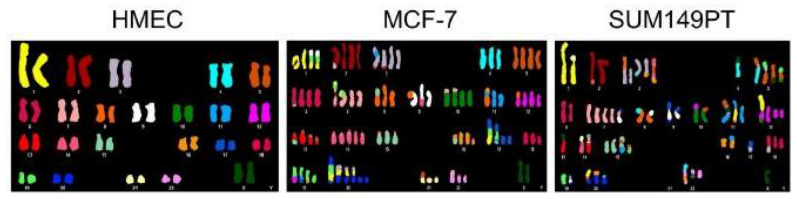
Figure 3. Cell lines derived from cancers exhibit numerical and segmental aneuploidy. Spectral karyotype comparison of normal human mammary epithelial cells (HMEC) and two breast cancer cell lines (MCF-7 and SUM149PT) that exhibit extensive numerical and segmental aneuploidy. Image reproduced from [106].